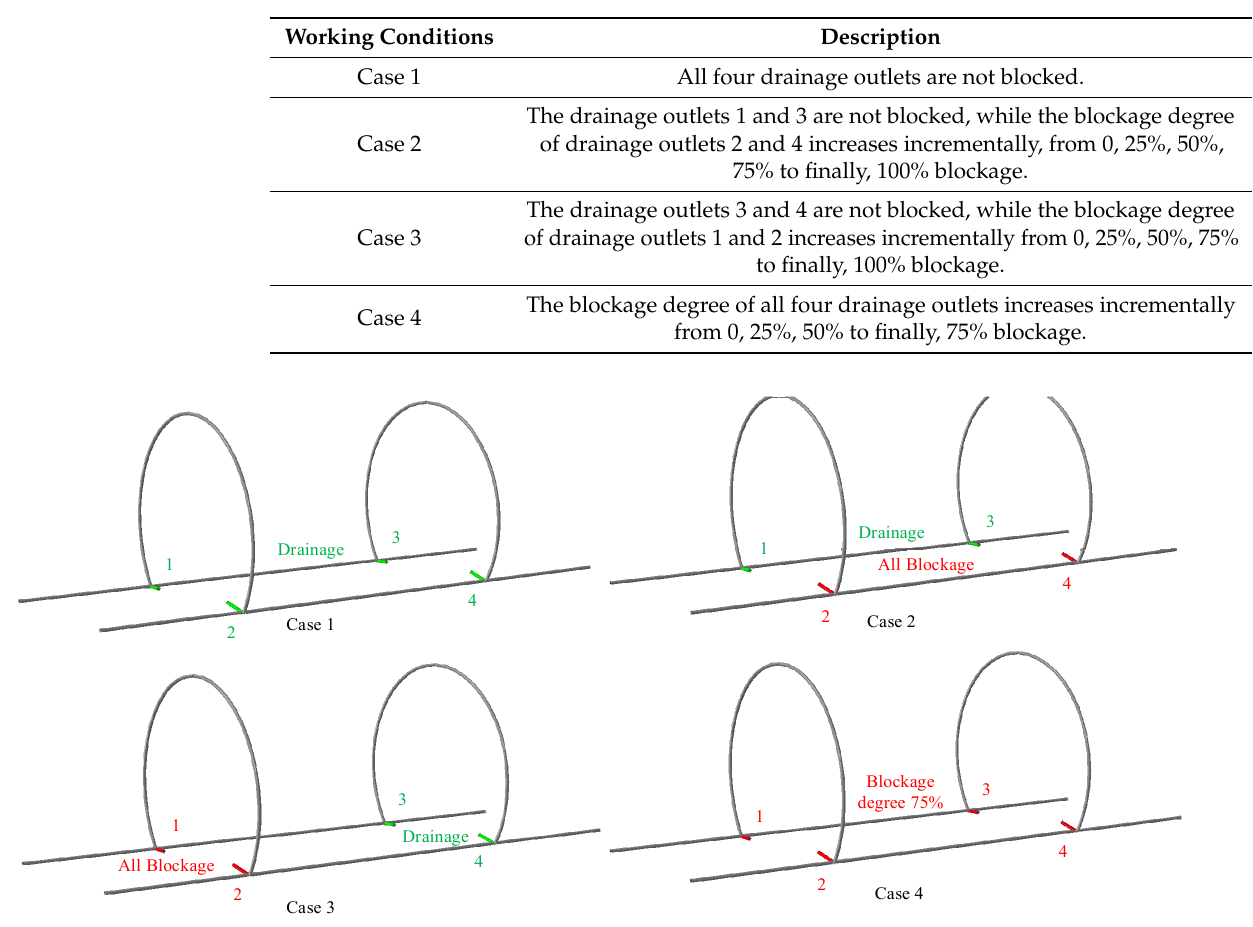
Figure 7. Diagram of the test